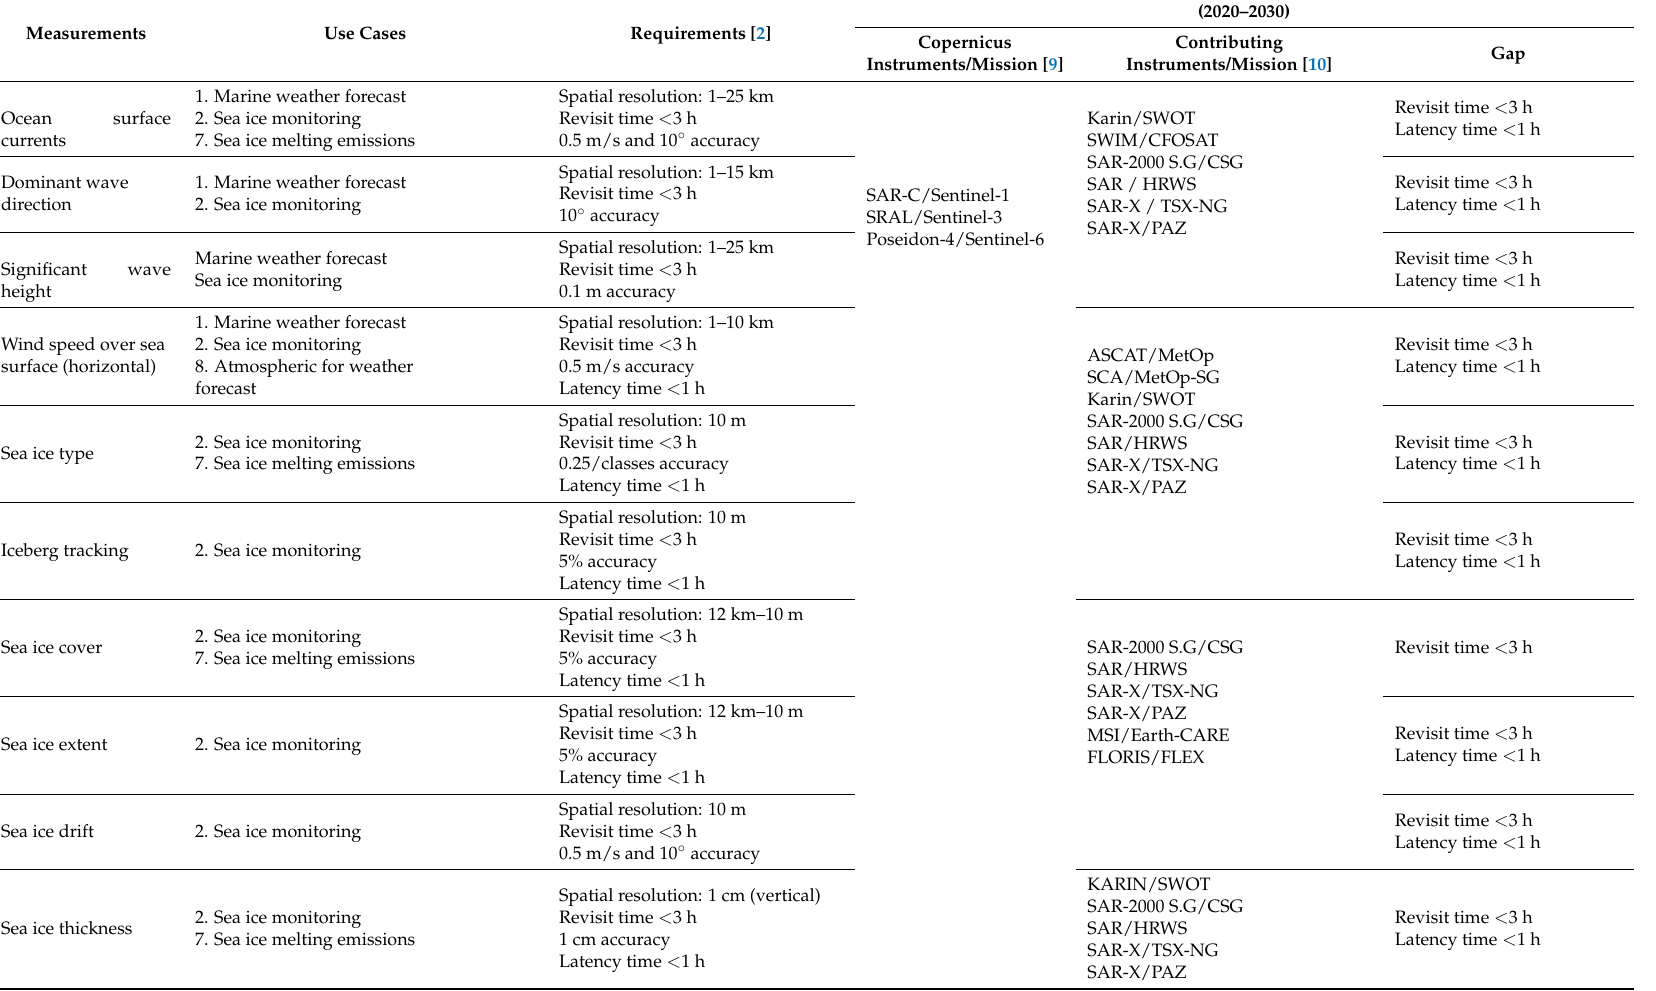
Table 2. Gap analysis results over the Copernicus space segment in the horizon